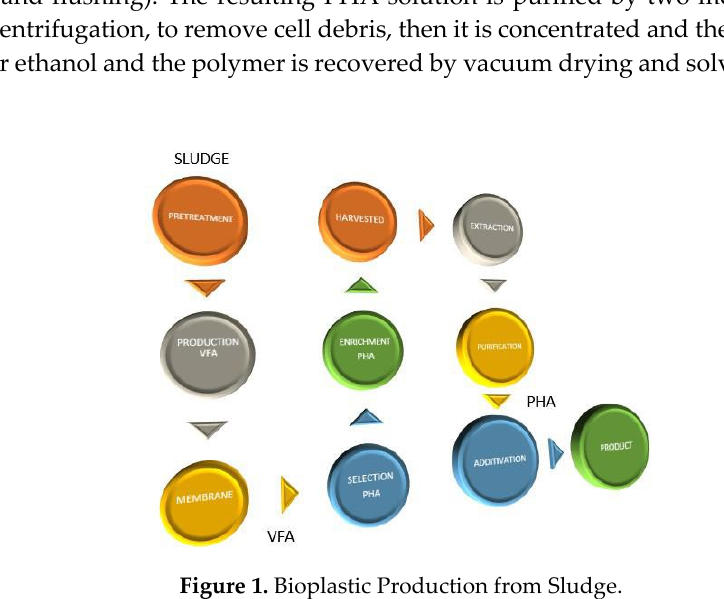
Figure 1. Bioplastic Production from Sludge.